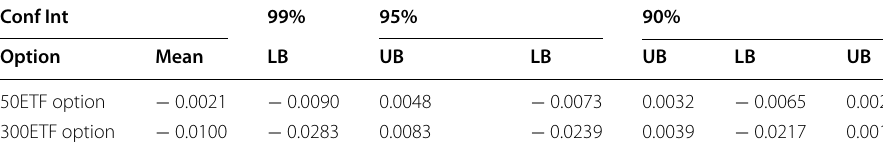
This table displays confidence intervals for the time series of realized option returns with the confidence interval in 99%, 95%, and 90%